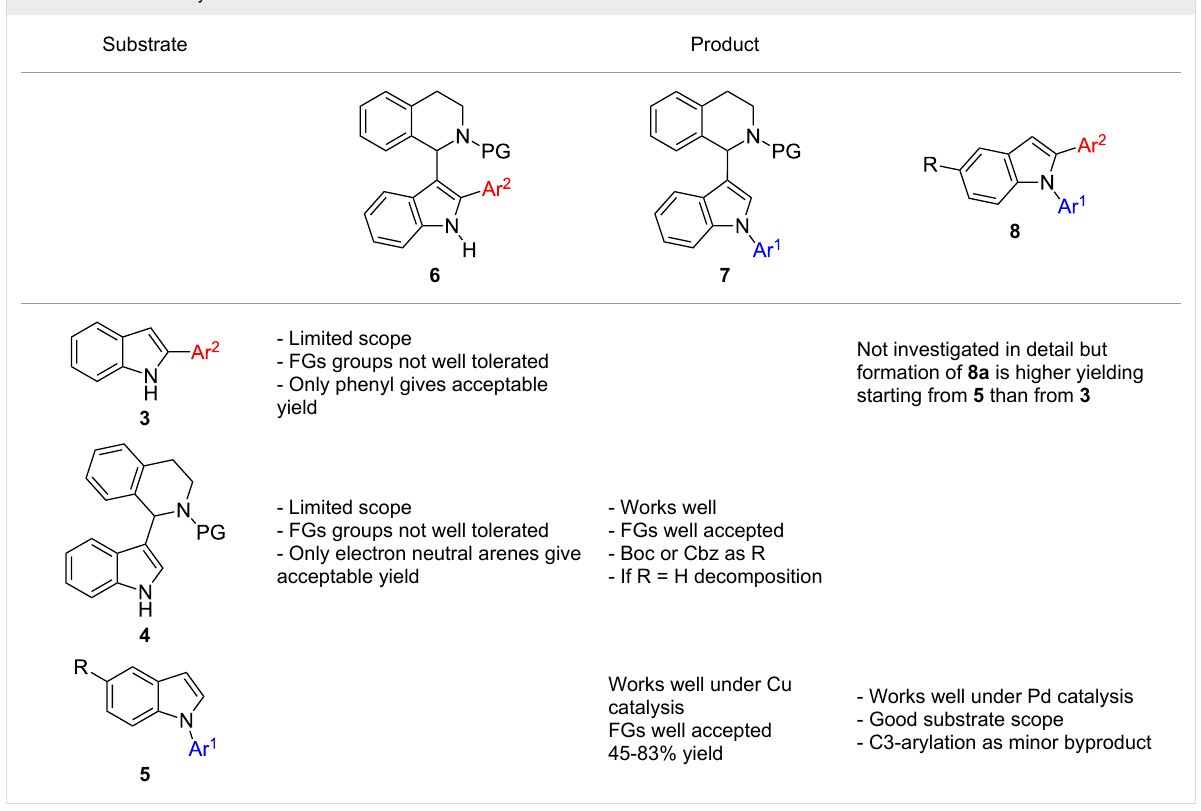
Table 7: Overview of synthetic efforts towards intermediates 6 – 8 .